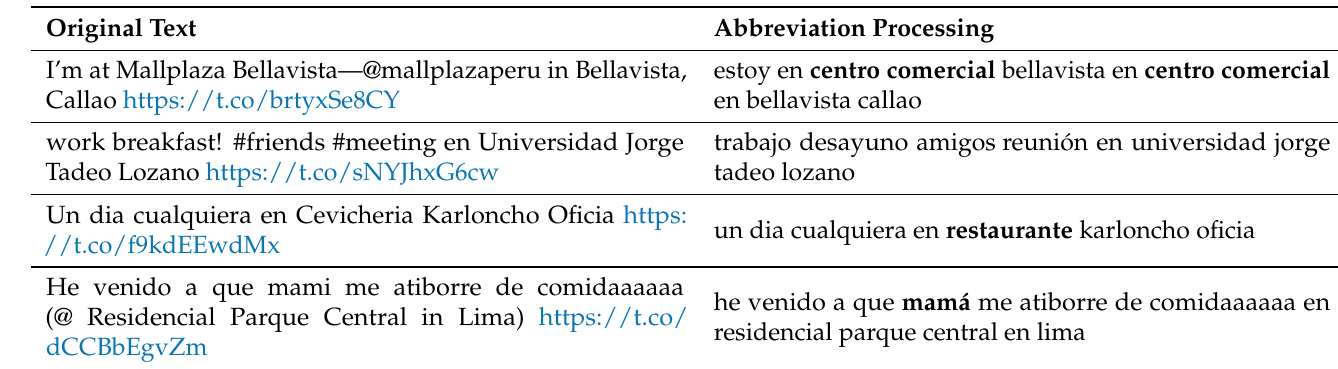
Table 4. Text output after processing abbreviations, acronyms, slang, and establishment